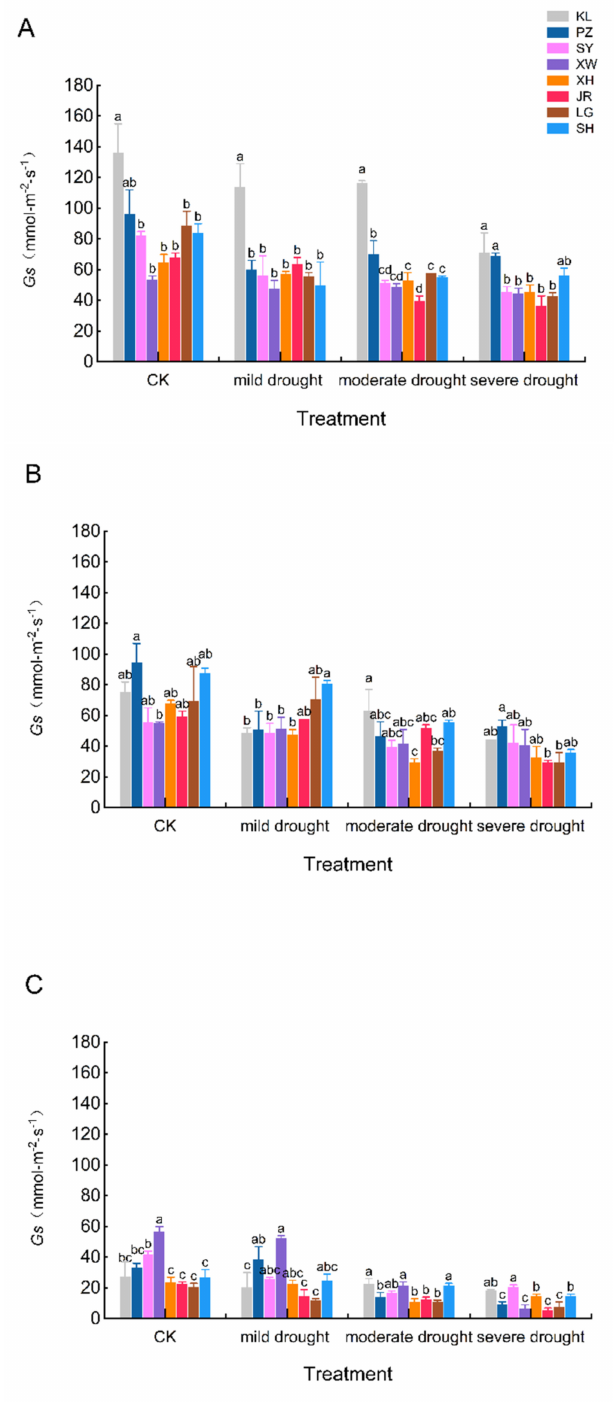
Figure 6. The stomatal conductance of Melia azedarach among different provenances: ( A ): early stage, ( B ): middle stage, and ( C ): late stage. Note: The error line in the figure is the mean ± standard error, and different lowercase letters in the same treatment indicate significant differences at the 0.05